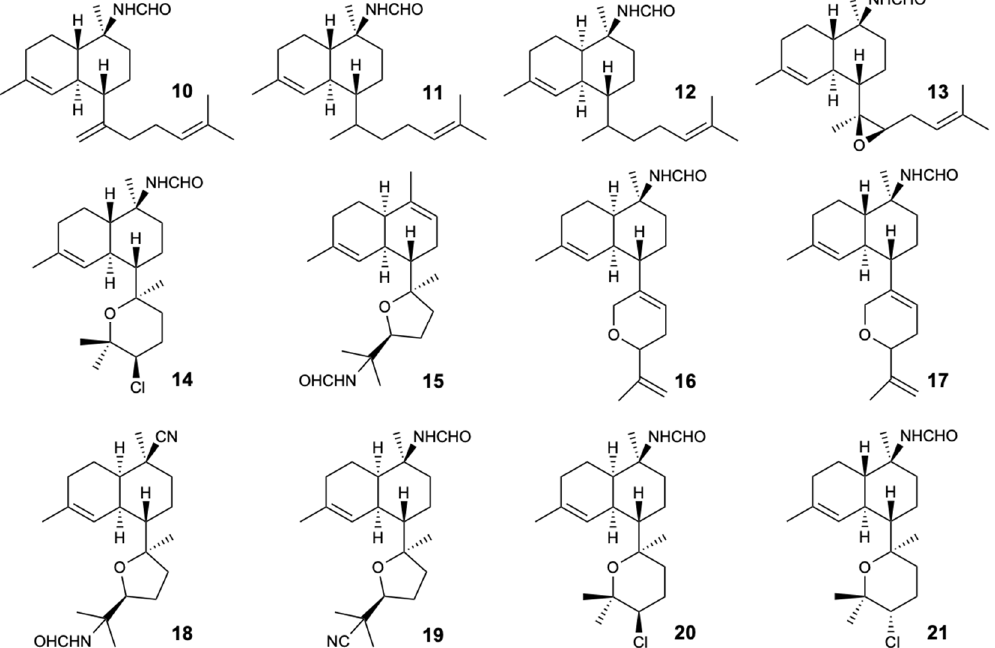
Figure 7. Structures of compounds 10 – 21 .